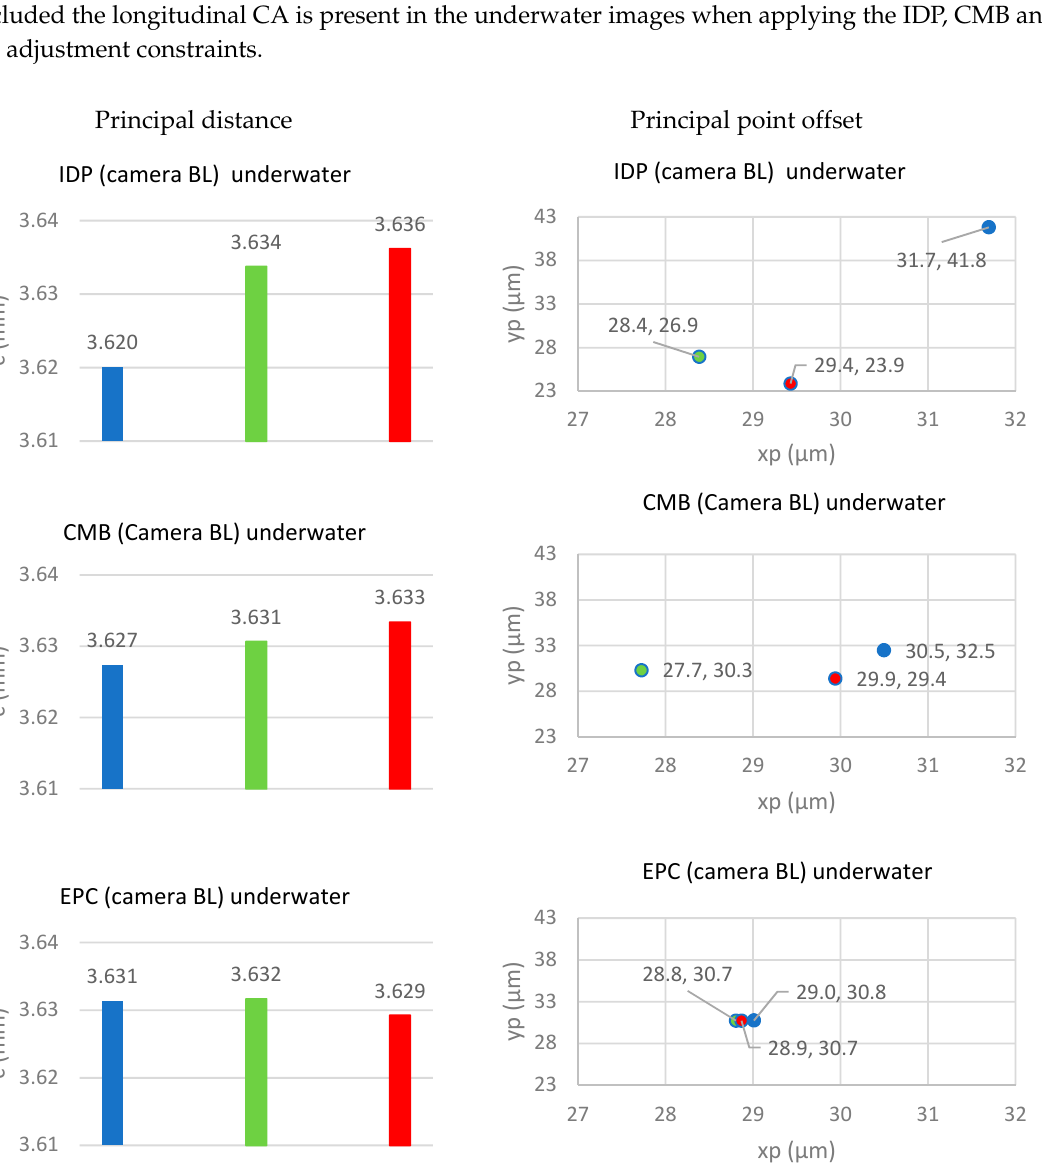
Figure 9. Comparison of the calculated principal distances ( right column) and principal point offsets ( left column) for the three different adjustment constraints (rows) for the camera FL calibrated under water. The colours indicate the results for the different bands (blue, green, red).